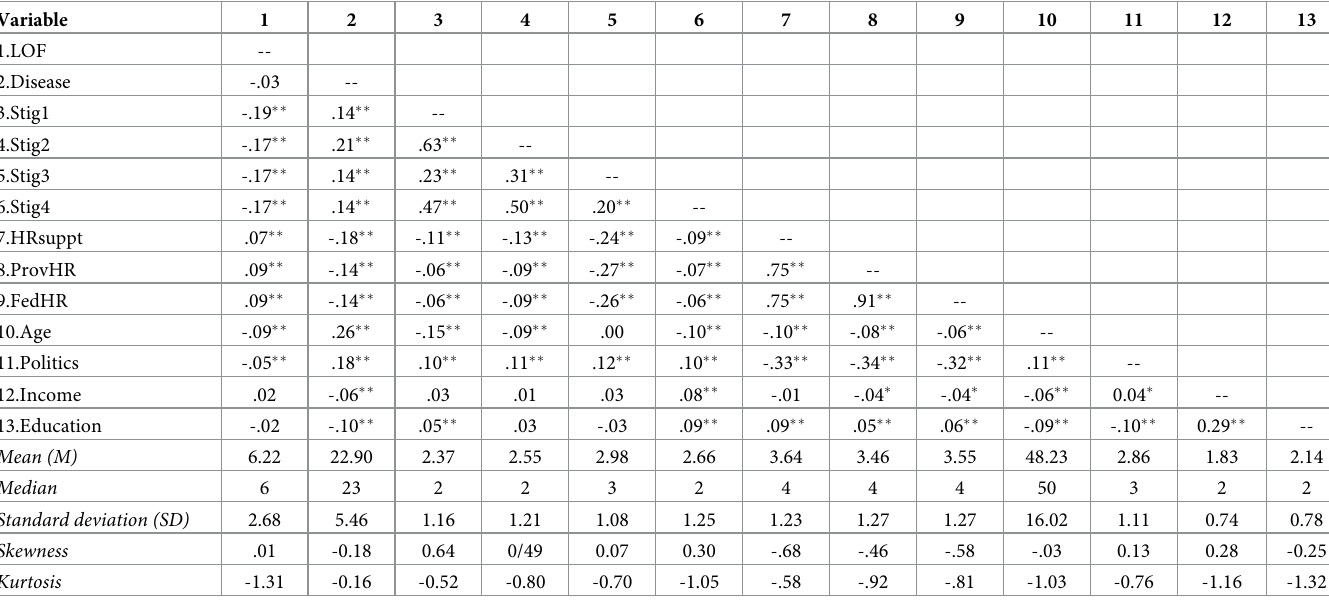
Table 2. Descriptive statistics and correlations among continuous study variables (N =